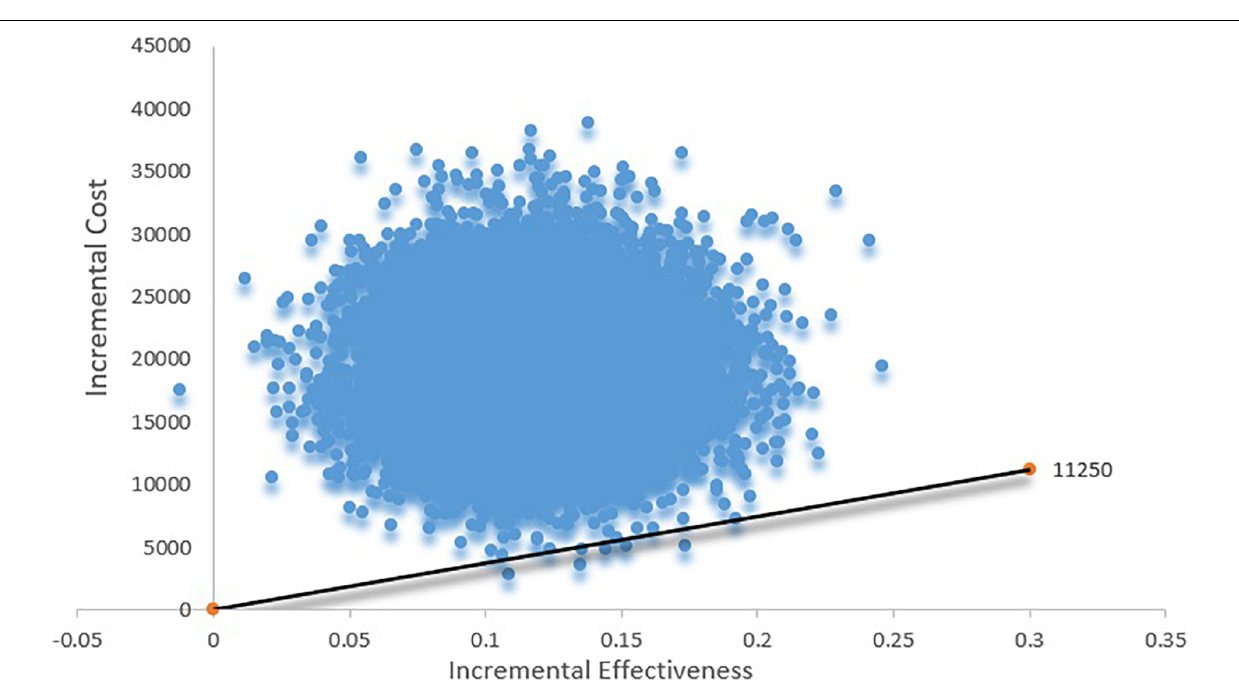
FIGURE 4 | Scatter plot based on probabilistic sensitive analysis. The probability that TAVR is cost-effective is less than